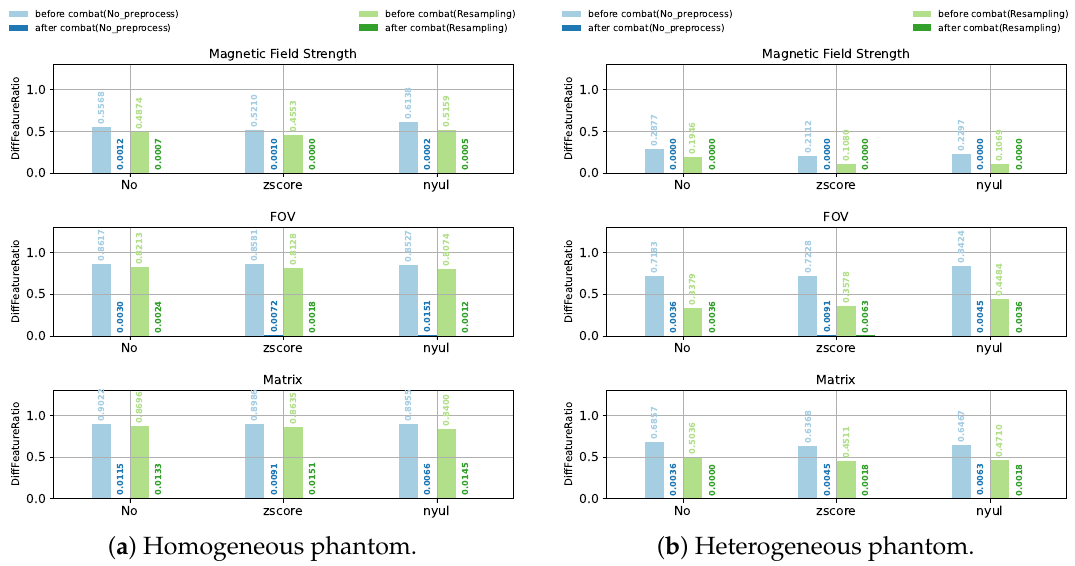
Figure 5. Impact of different preprocessing and harmonization methods for ( a ) homogeneous phantom data and ( b ) hetero- geneous phantom data. N4 bias field correction was not considered for phantom